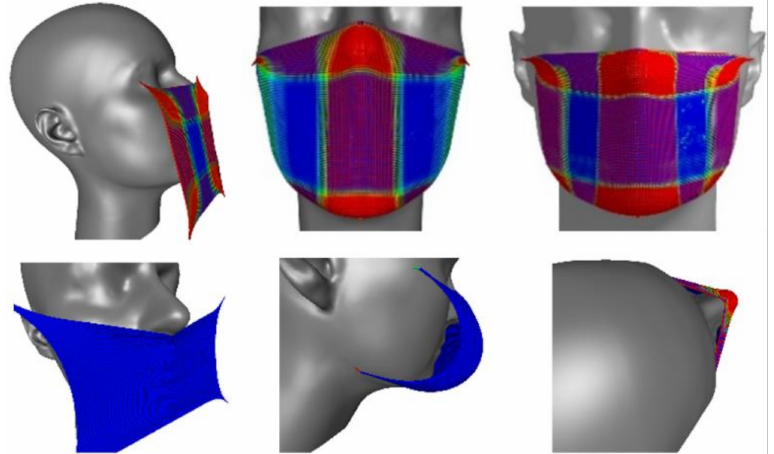
Figure 20. Simulation of putting on a mask with the yarn resolution. Colors provide informa- tion about tension. The influence of face shape and knitting tension on the mask fitting form is demonstrated. ©Fraunhofer